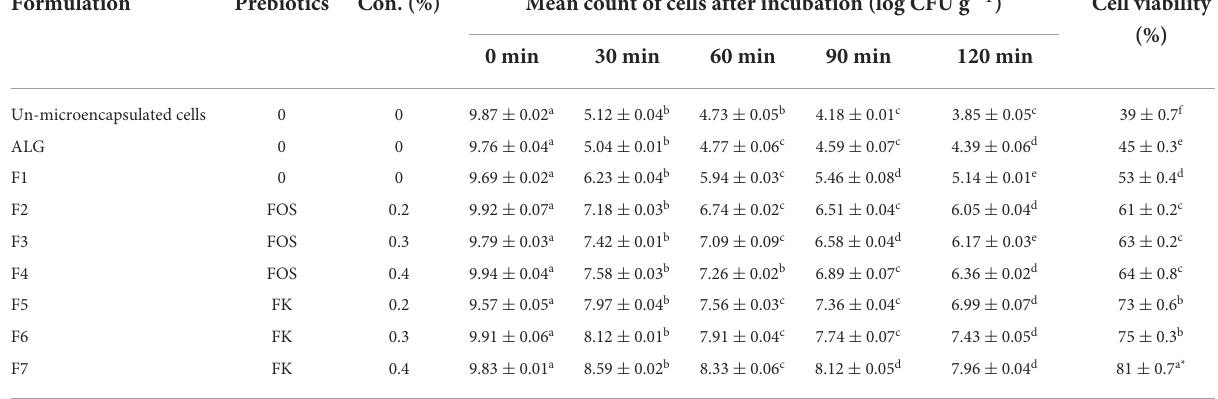
TABLE 3 Cell viability of microencapsulated Enterococcus faecium with various gel and prebiotic concentrations after incubation in simulated fish gastric juices (0.08M HCl containing 0.2% NaCl, pH 1.4) for 0, 30, 60, 90, and 120min and sequentially in stimulated fish intestinal juice containing (0.5% w/v oxgall, pH 8 at 37 ◦ C for